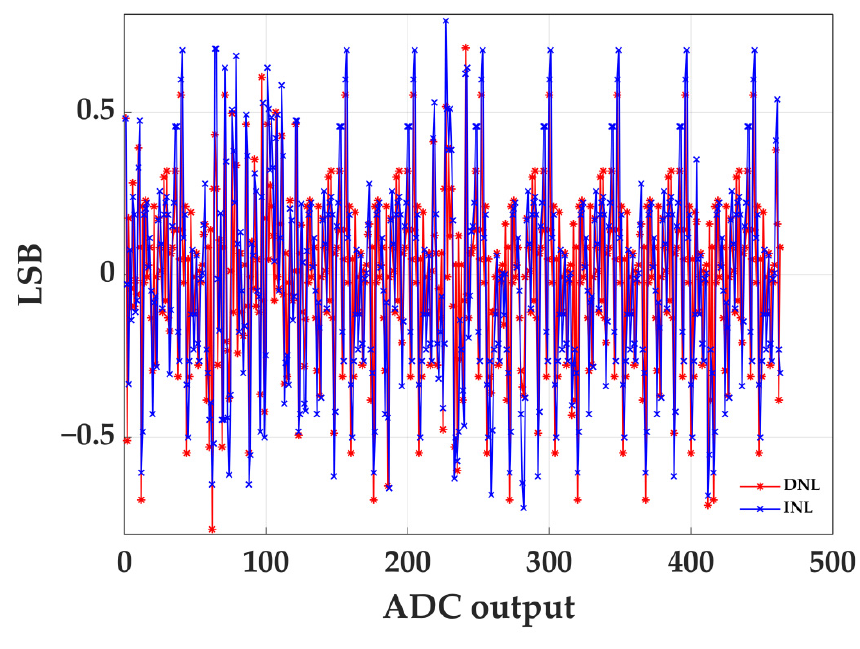
Figure 13. Measured DNL and INL of ADC.